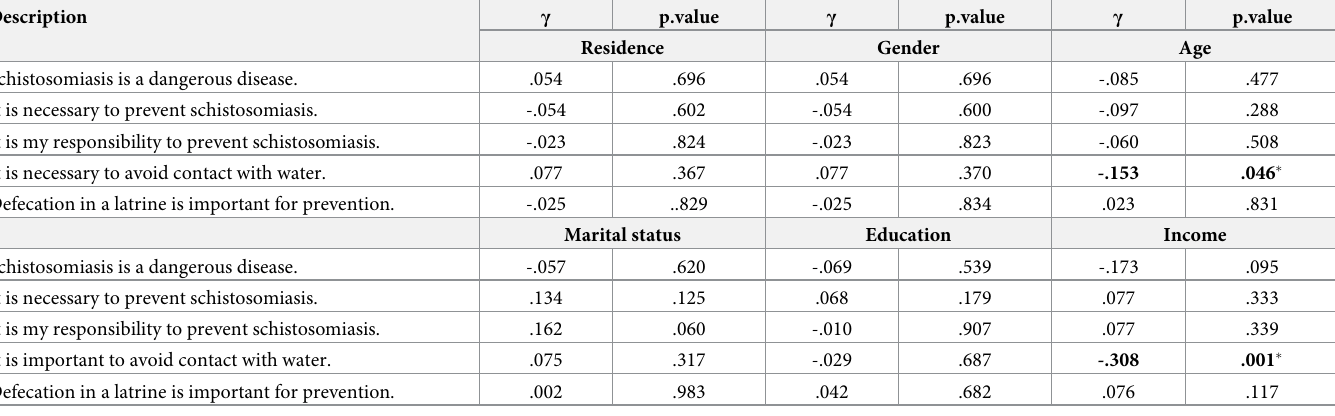
Table 5. Association between respondents’ sociodemographic characteristics and attitude regarding schistosomiasis.